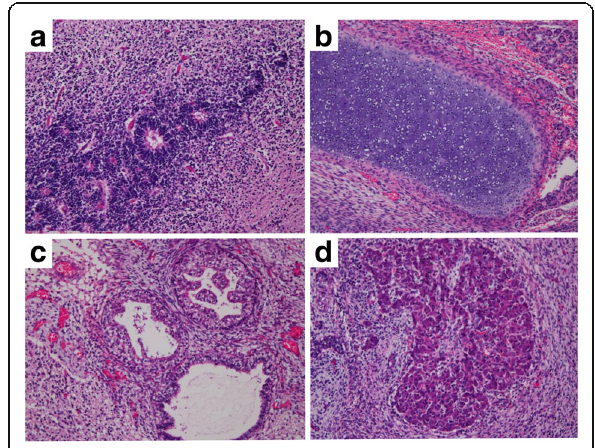
Fig. 5 Microscopic images of tridermal components in the intracranial tumor. a Immature neural tubules (hematoxylin and eosin [HE] stain, × 100). b Cartilage (HE stain, × 100). c Esophagus (HE stain, × 100). d Hepatocytes (HE stain, ×